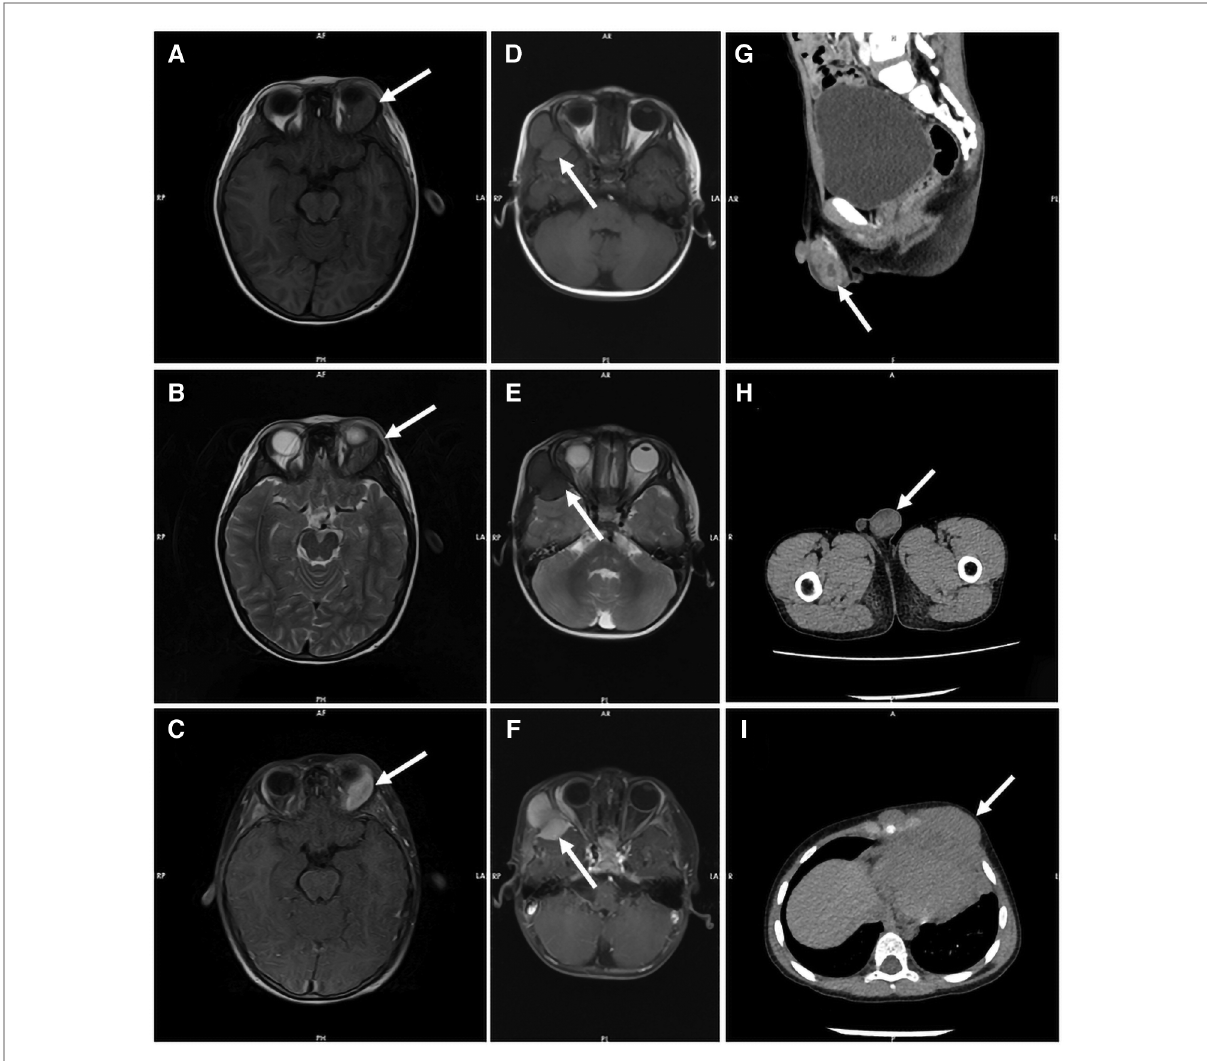
FIGURE 1 Radiological data on part patients. Both T1-weighted MR images ( A ) and T2-weighted MR images ( B ) showed equal signal intensity in the left orbital region of patient 2, which was signi fi cantly enhanced by contrast agent injection ( C ). T1 weighted MR images showed equal signal intensity ( D ), and T2 weighted MR images showed low signal intensity ( E ) in the frontal and temporal lobes of patient 6, with uniform enhancement and adjacent brain parenchymal compression ( F ). CT showed mass soft tissue density foci from the testis of patient 11 ( G and H ) and the mediastinum of patient 9 ( I